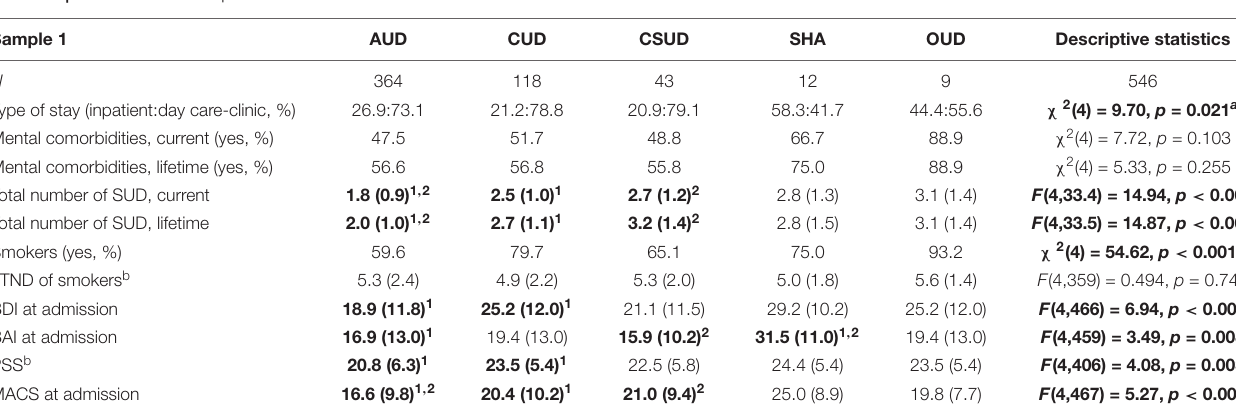
TABLE 2 | Clinical data of sample